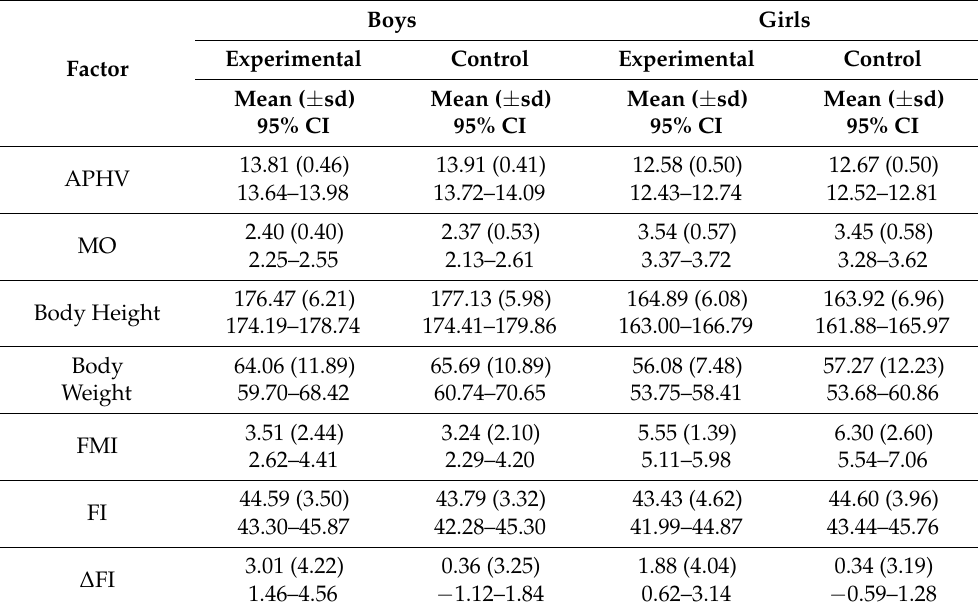
Table 1. Biological age, anthropometric measurements, body composition, and fitness index at baseline